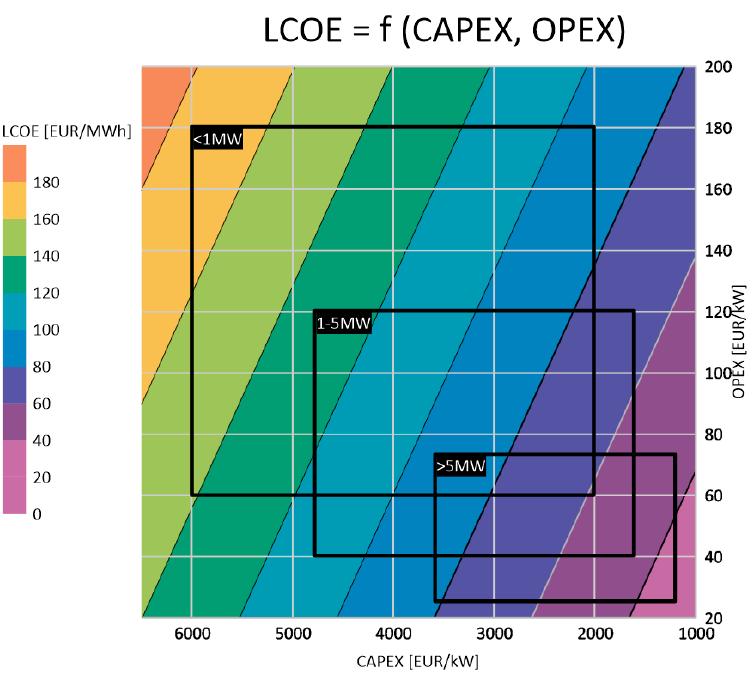
Figure 1. The total cost LCOE–WACC rate of 7% and life time 50 years. Source: own elaboration. The first (from the right side) purple fields in the diagram represents the LCOE below EUR 60/MWh—this level of LCOE can be achieved with CAPEX of less than EUR 2600/kW and correspondingly low OPEX. For example, for CAPEX of EUR 2000/kW, OPEX can be up to EUR 65/kW. This LCOE range can reach medium hydropower (>5 MW) where